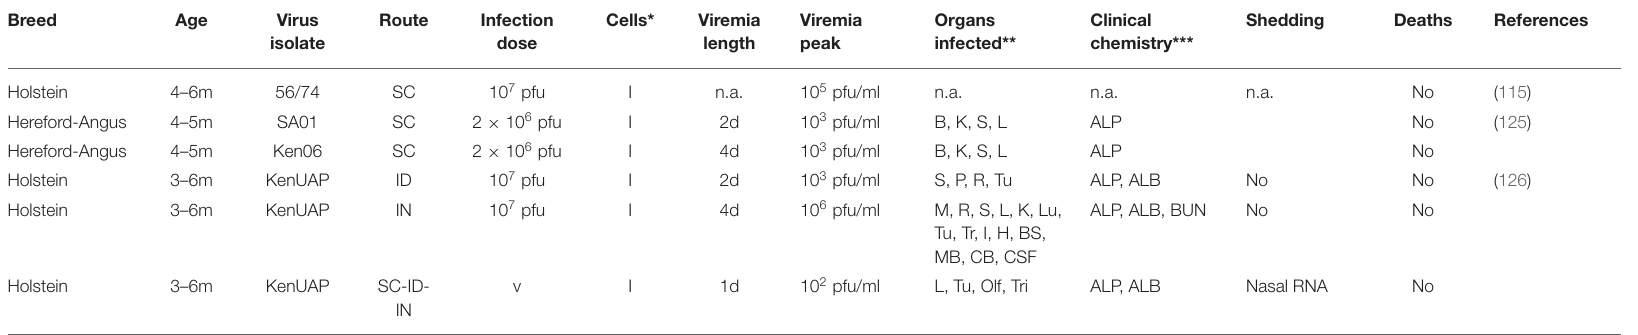
TABLE 4 | Summary of included cattle studies involving RVFV